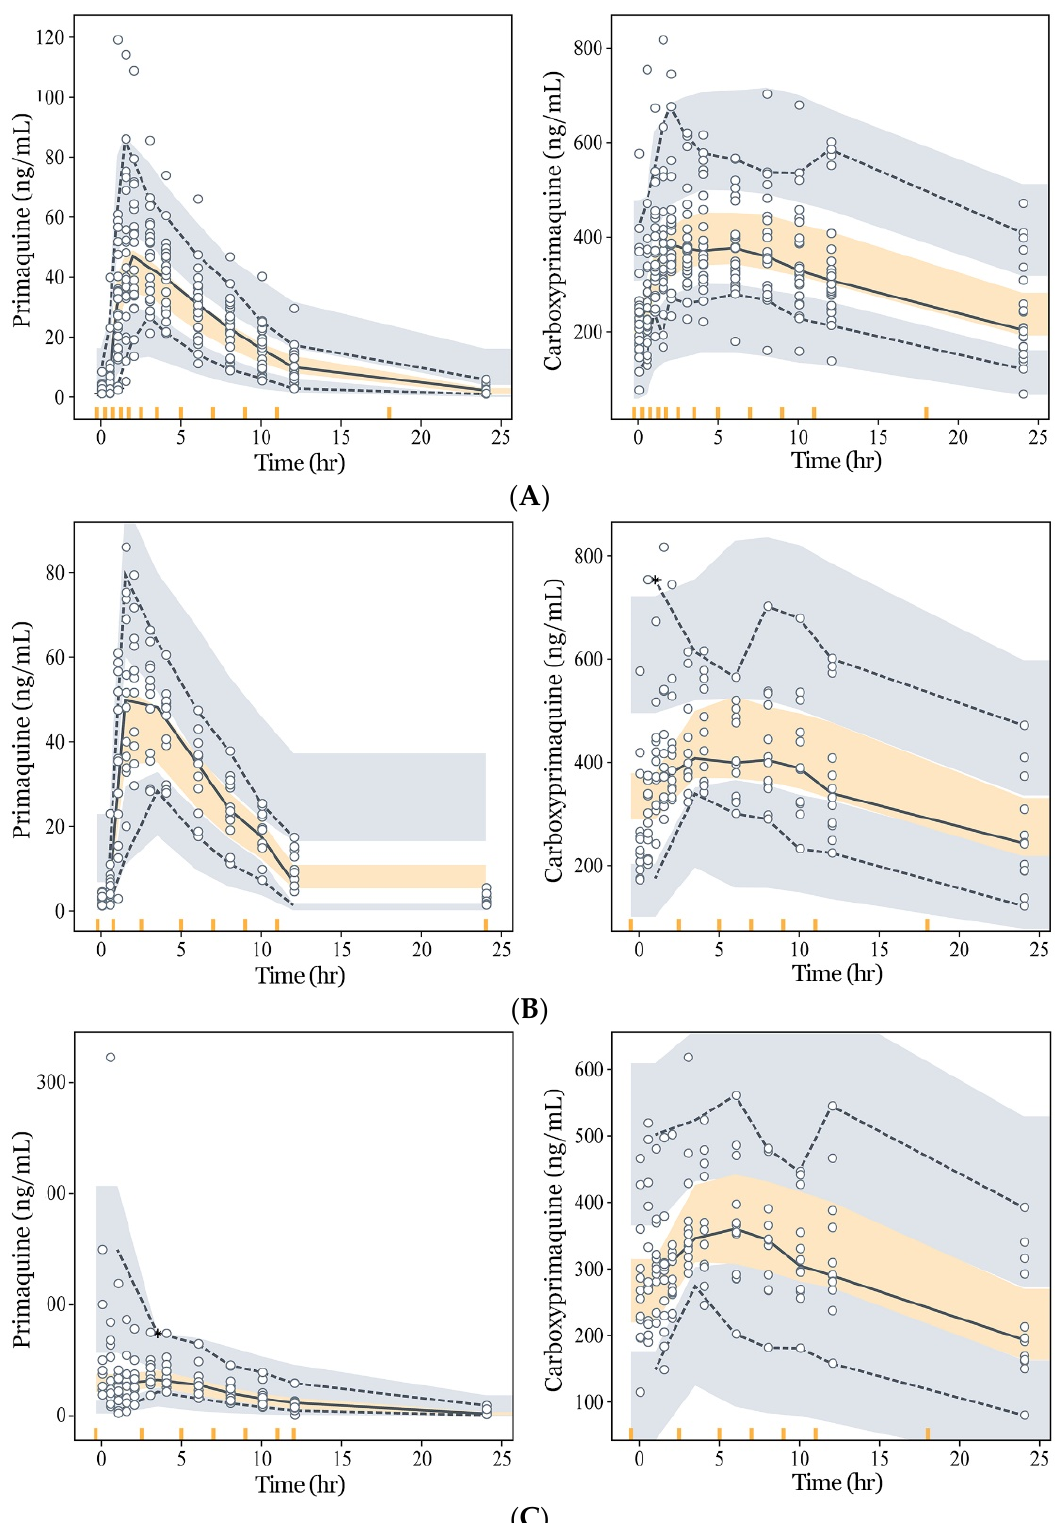
TOP: Observed concentrations (dots), their smooth (dotted line), and population predictions (solid line) vs time for CPQ, MIDDLE: Observed concentrations vs population predictions (left) and vs individual predictions (right) for CPQ (solid line: smooth; dashed line: line of identity); BOTTOM: Conditional weighted residual vs population prediction (left) and vs time (right) for CPQ (solid line: smooth; dashed line: line of zero residual). OBS, observation; PRED, prediction.